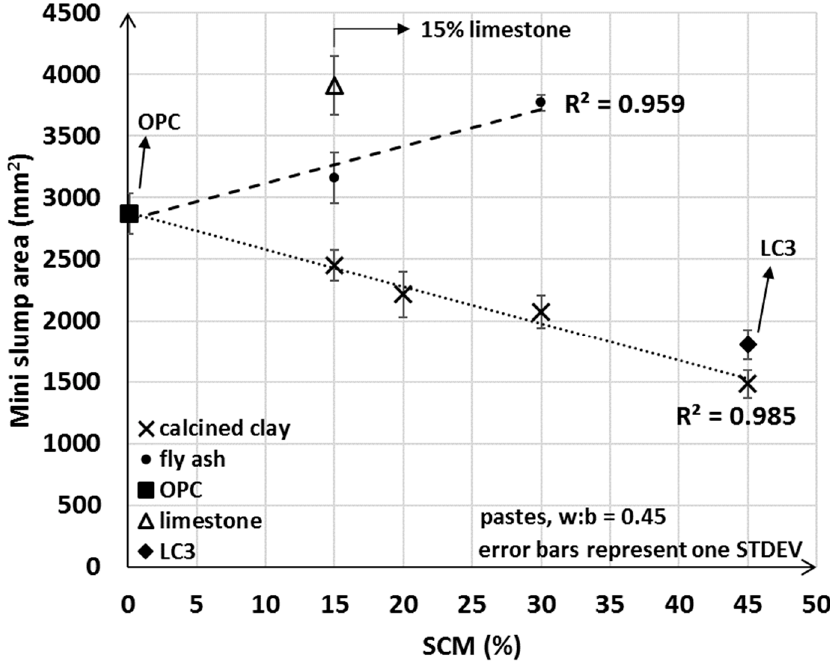
Figure 5. Average mini slump values of OPC, limestone, LC3 and various fly ash and calcined clay blends.